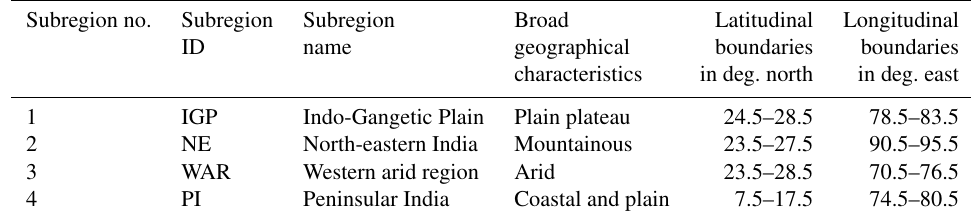
Table 1. Details of subregions considered. Subregion no.